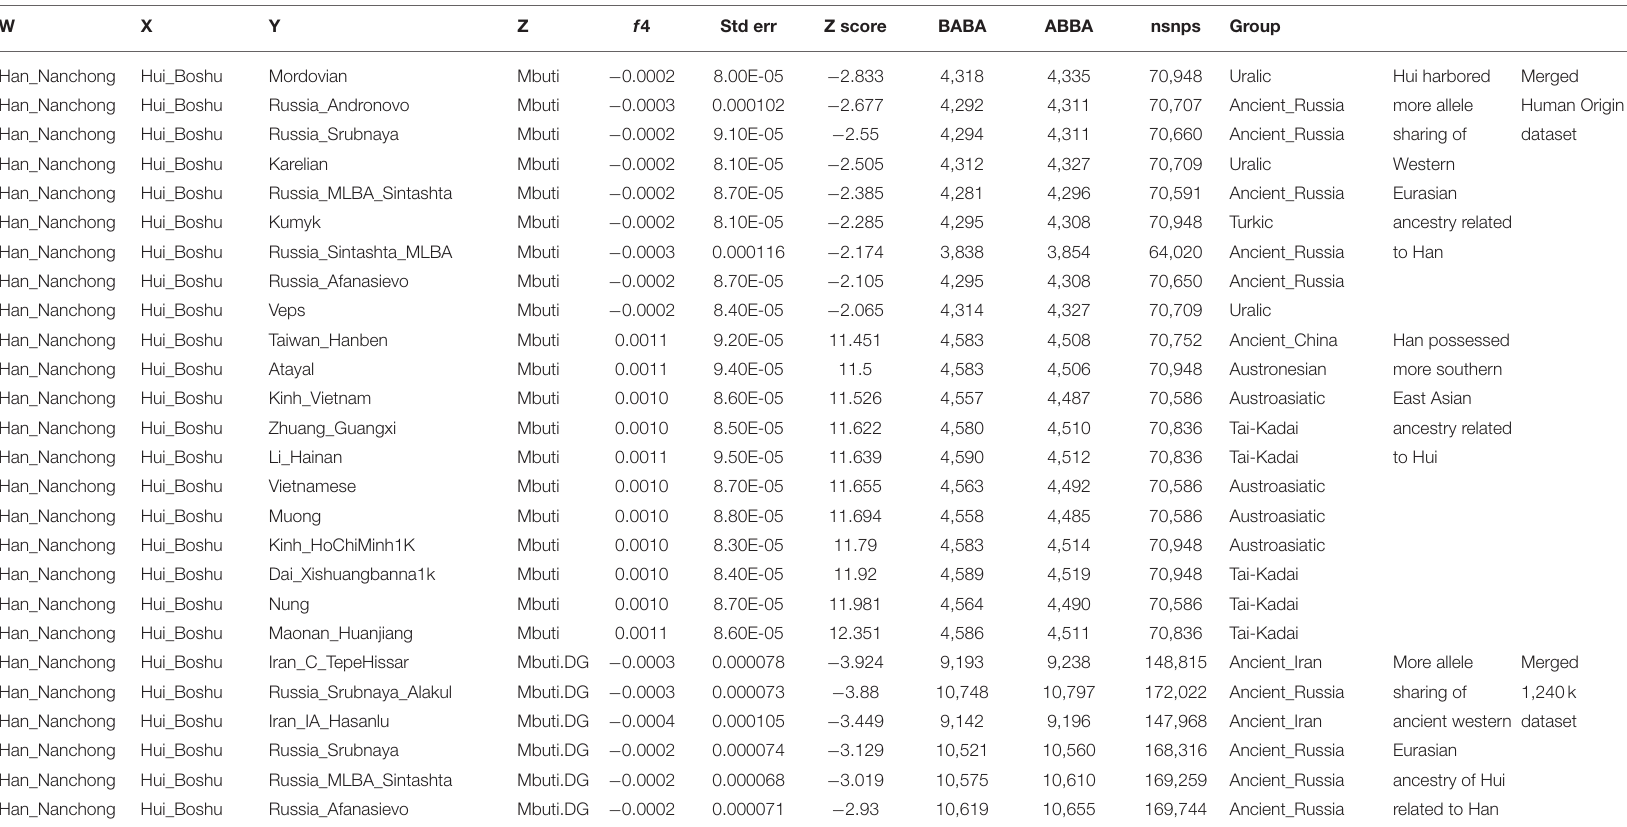
TABLE 1 | Differentiated shared alleles between Boshu Hui and Nanchong Han compared to modern and ancient Eurasians estimated via symmetrical f 4 -statistics in the form f 4 (Han_Nanchong, Hui_Boshu; Eurasian, Mbuti) based on the merged 1,240K and Human Origin